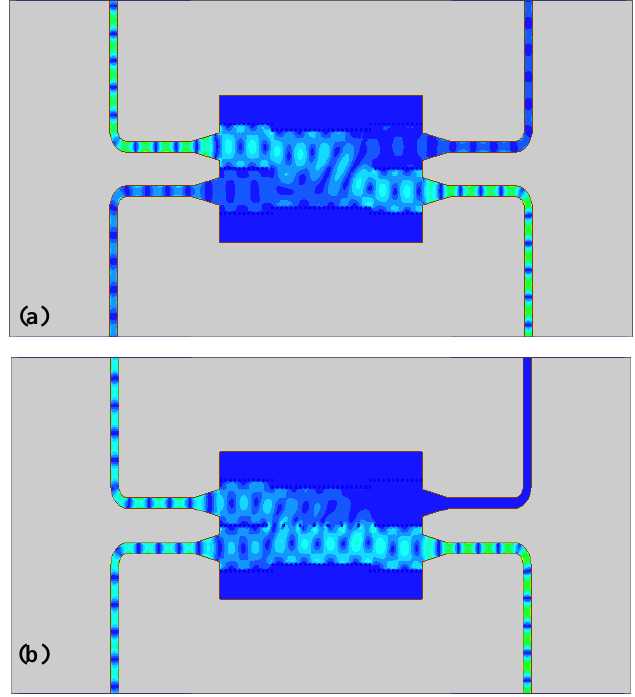
Figure 5. Simulated current distribution at 35 GHz for (a) single hole model (b) multi hole